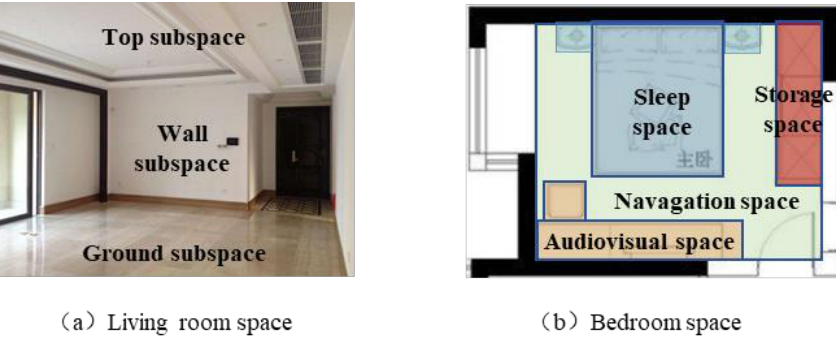
Figure 7. Schematic diagram of indoor functional subspace.